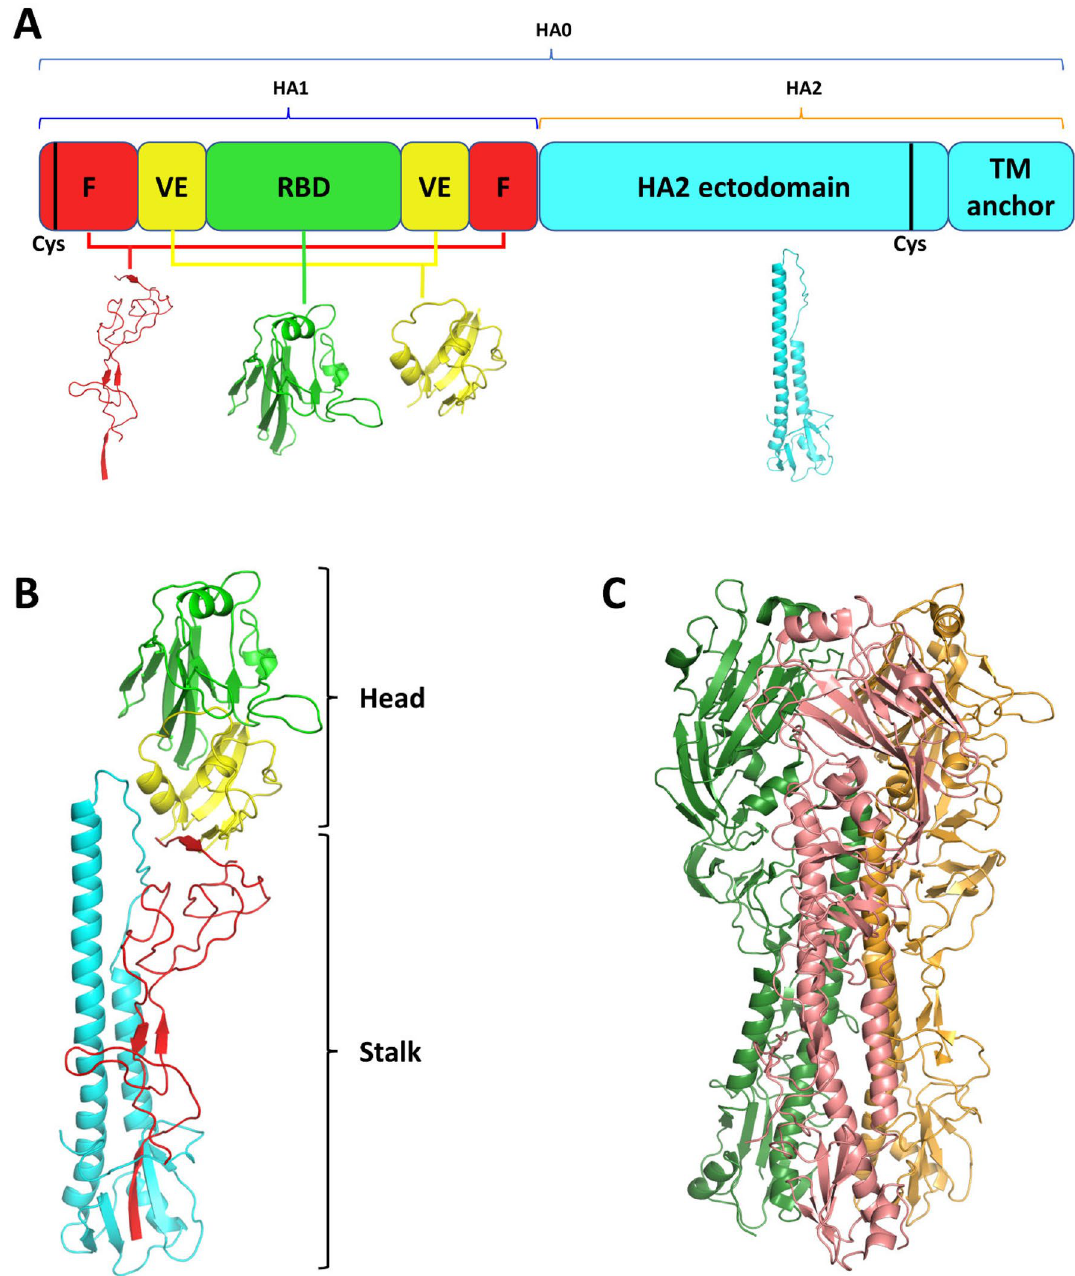
Figure 1. Influenza virus A hemagglutinin (HA) protein structure. ( A ) Schematic view of HA domains. F fusion domain (red), VE vestigial esterase domain (yellow), RBD receptor binding domain (green), TM anchor transmembrane anchor (cyan). The structure of each domain is shown under its schematic equivalent. Black lines depict cysteines that are responsible for disulfide bonds between HA1 and HA2. ( B ) Structure of A/ Denver/57/1957 HA protomer (PDB ID: 6ML8), coloured by different domains. Colour coding as per panel ( A ). ( C ) Trimeric quaternary structure of HA, coloured by